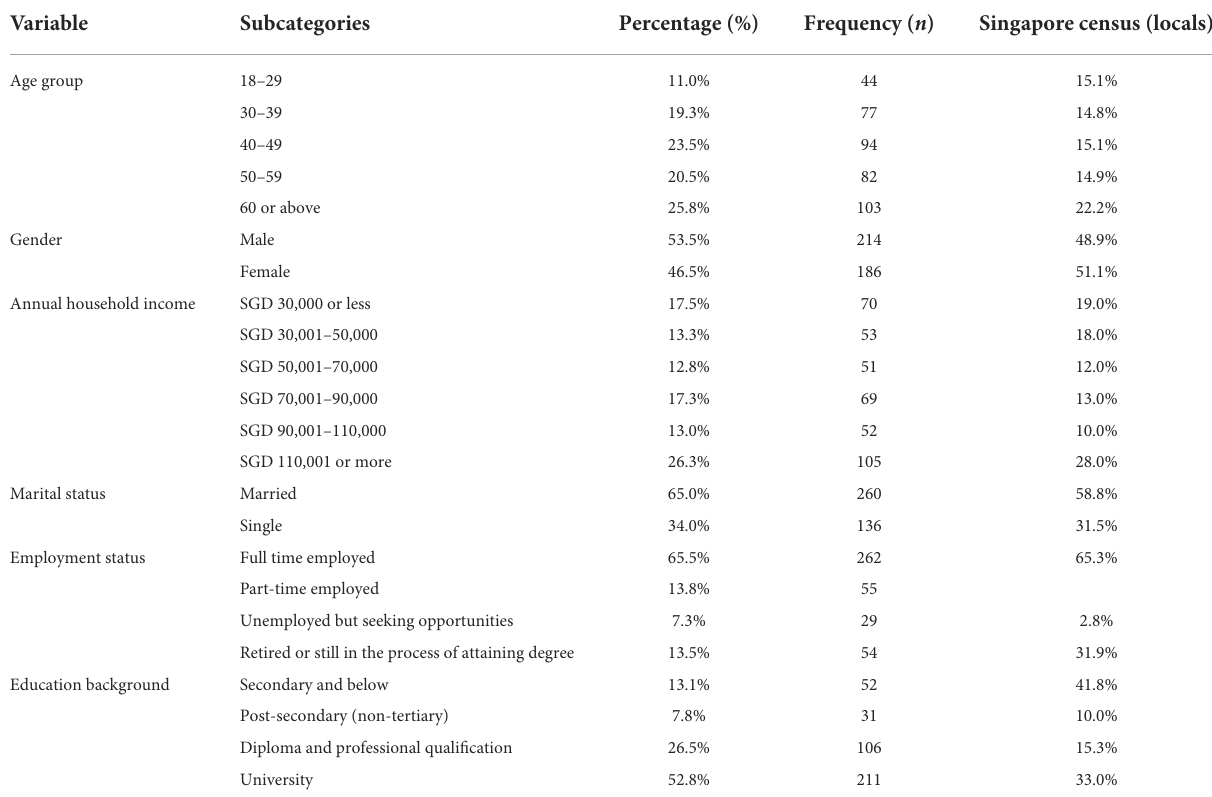
TABLE 4 Demographic distribution of